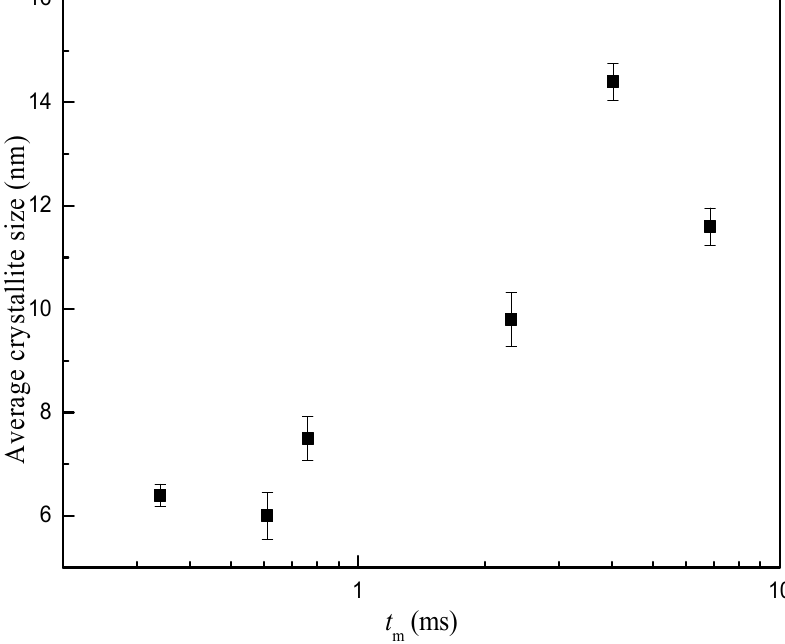
Figure 5. Average crystallite size variation with micromixing time.